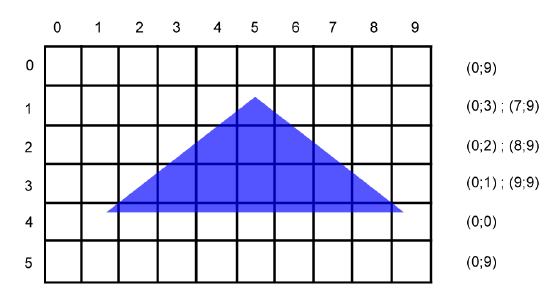
Figure 2. The BAM stores free scanline segments, here for a 10 × 6 texture atlas containing a single triangular texture patch Beyond the runtime the placement stage also anticipates render issues that will occur with graphics adapters which implement mipmaps, that is, pyramids of downscaled textures for differ- ent display resolutions. As the mipmap generator typically uti- lizes digital low-pass finite impulse response filters for resam- pling nasty transitions from the texture patches to the background color of the atlas bitmap are likely to appear when the building model is visualized. To circumvent this problem the patches P i are added a safety margin before they eventually will be placed. This safety margin is calculated by offsetting the contour of each texture patch polygon along its outwardly oriented vertex normals and results in extended source texture coordinates ( s i , t i ) → (˜ s i , ˜ t i )